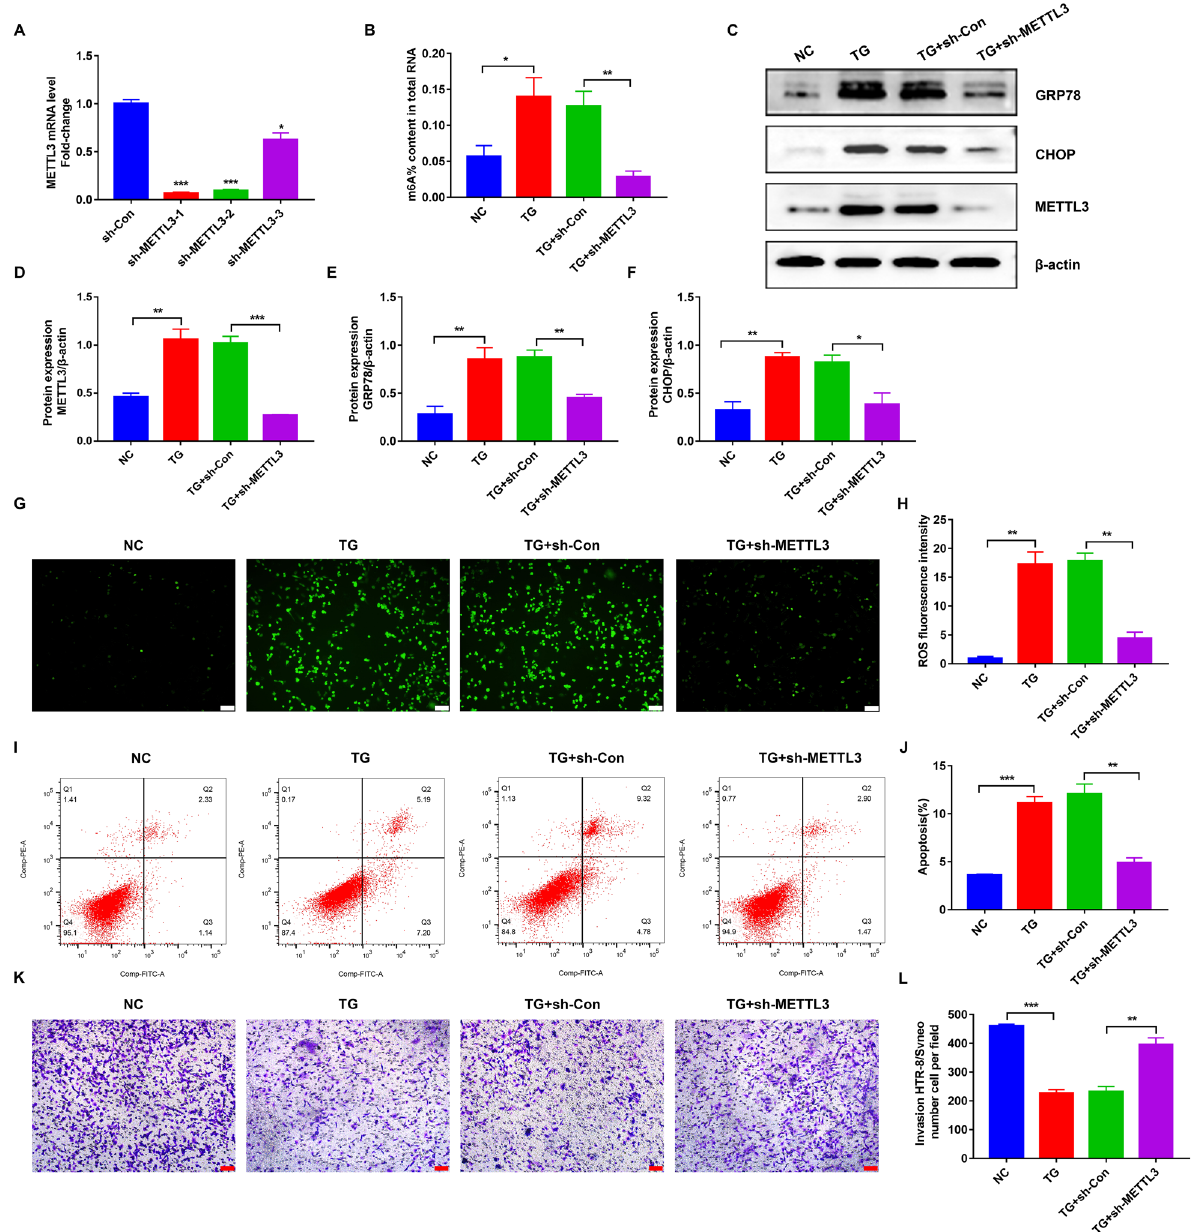
Fig. 3 Attenuated ER stress, decreased ROS production and apoptosis rate in TG-treated HTR-8/SVneo cells by knockdown of METTL3. A The knockdown efficiency of different sh-METTL3s determined by qRT-PCR. B The m 6 A level in different groups determined by m 6 A colorimetric assay. C – F Representative WB images and densitometry quantification of METTL3, GRP78 and CHOP. The data were normalized to β-actin. G , H ROS production detected by DCFH-DA. Photographs were obtained at 100 ( Scale bar 100 μm). I , J Apoptosis rate in different groups detected by flow × cytometry. K Representative transwell photos of HTR-8/SVneo cells in different groups (100 magnification, Scale bar 100 μm). L Qualified data × shown in K . n 3. *p < 0.05, **p < 0.01, ***p < =